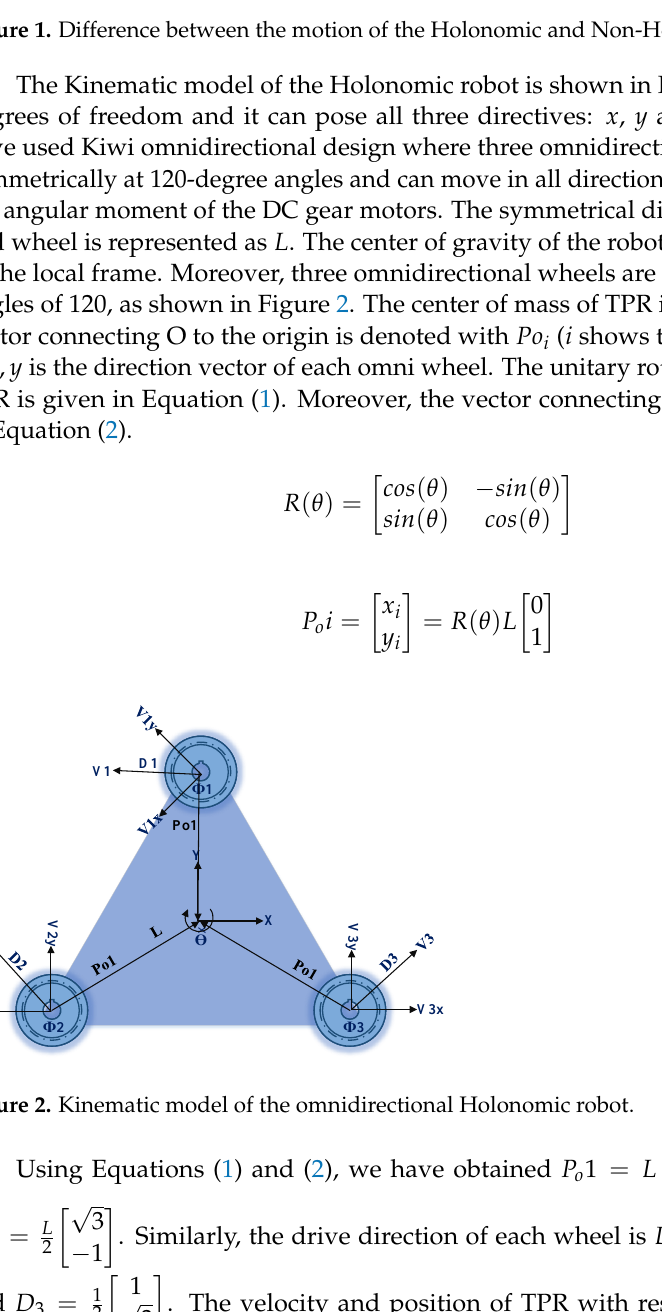
. The velocity and position of TPR with respect to the global